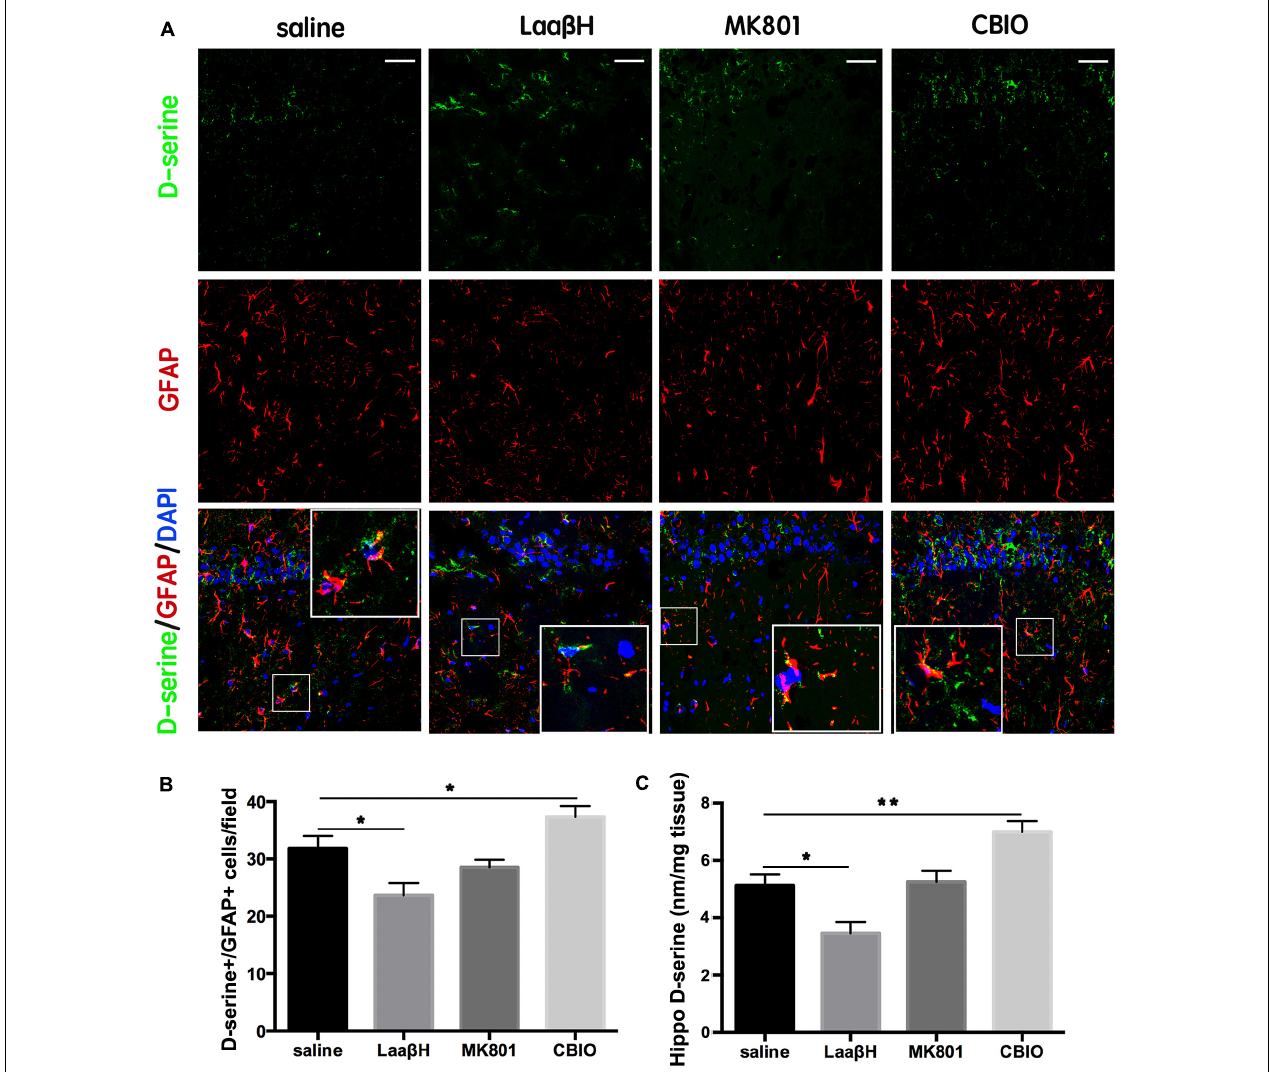
FIGURE 3 | Effects of MK801, Laa β H and CBIO on the expression of D-serine in the hippocampi of rats. (A) Double-immunostaining for GFAP/ D-serine in the hippocampi of rats that experienced seizures and were treated with saline, Laa β H, MK801, or CBIO. (B) Quantification of the GFAP/D-serine double positive cells shown in (A) . (C) HPLC analysis of D-serine levels in hippocampus of rats treated by saline, Laa β H, MK801, or CBIO. Notice the decrease of D-serine in the Laa β H-treated rats and increase of D-serine in the CBIO-treated rats. Inserts are magnified double positive cells. ∗ P < 0.05, ∗∗ P < 0.01. Bars = 50 µ